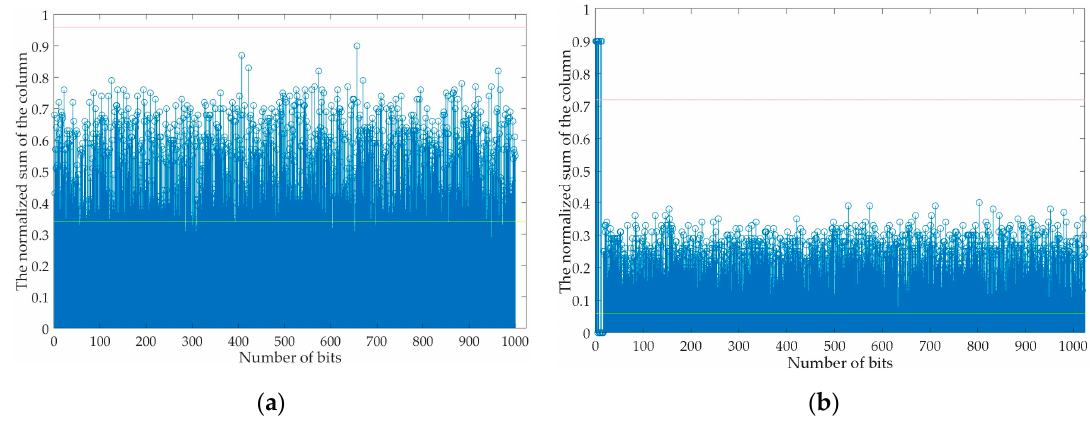
Figure 6. Result of the frame synchronization code recognition: ( a ) no peak appeared if there was no frame synchronization code, and ( b ) a clear peak appeared if there was a frame synchronization code.